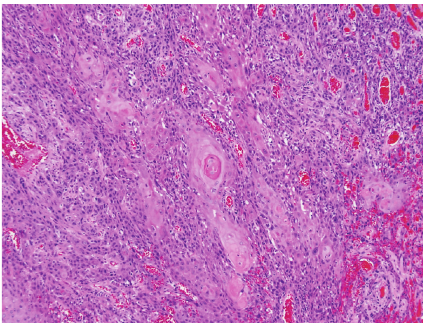
Figure 3: Higher magnification of Figure 2 demonstrating invasive, well-differentiated Squamous Cell Carcinoma with characteristic “whorl” pattern,